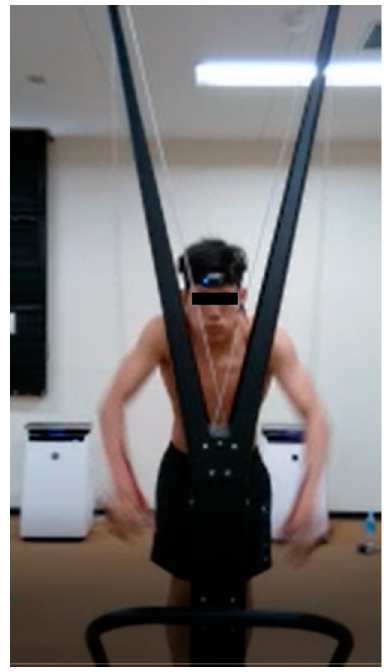
Figure 2. High Intensity Interval Training (HIIT) Training.